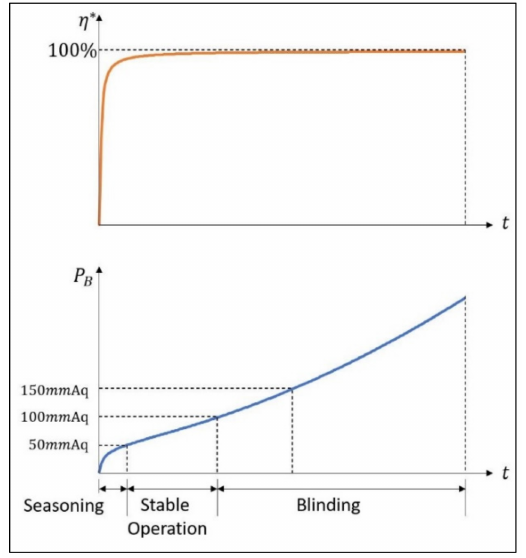
Figure 7. The changes in cleaning efficiency and pressure drop in the